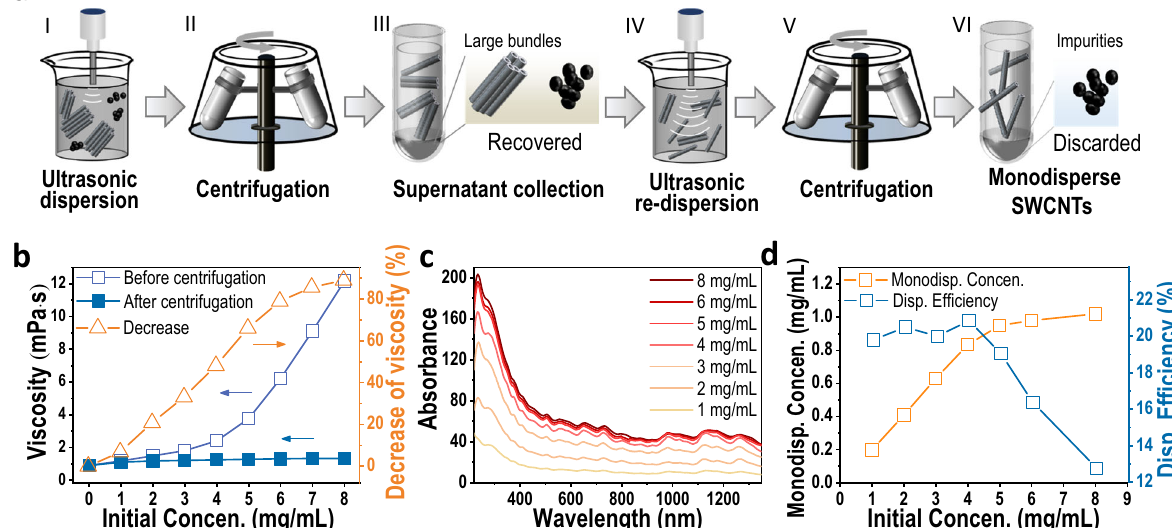
Fig. 1 | The preparation of a high-concentration individualized SWCNT solu- tion. a Schematic diagram of the preparation of high-concentration individua- lized SWCNT solution; b The relationship between the shear viscosity and initial concentration of SWCNT solution before and after the fi rst ultracentrifugation; c Optical absorption spectra of the as-prepared individualized SWCNTs with different initial concentrations; d The relationship between the initial SWCNT